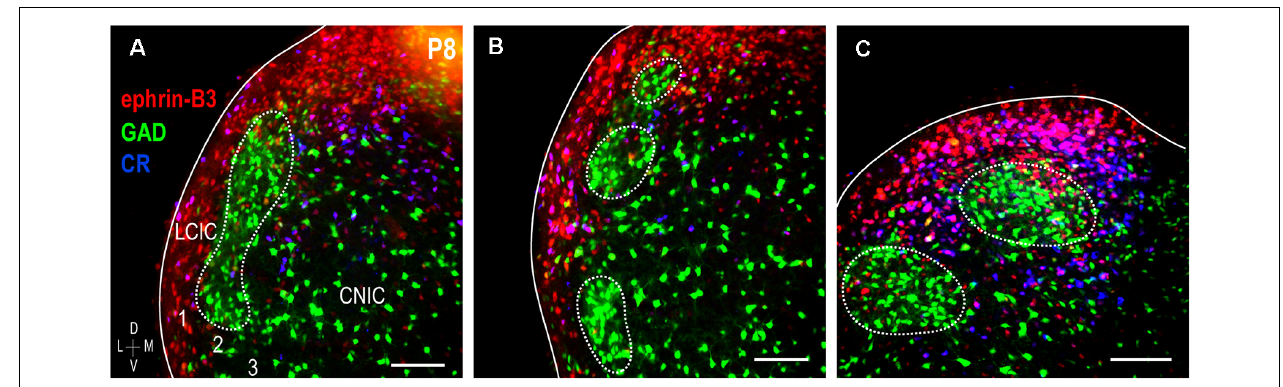
FIGURE 3 | Ephrin-B3 LCIC expression with respect to GAD (modular) and calretinin (CR; matrix) labeling at P8. Digital merges from a coronal series (A–C) through the modular extent of the LCIC at P8 [ephrin-B3 = red, GAD = green, calretinin (CR) = blue]. Dashed contours indicate the change in the appearance of GAD modules along the caudal-to-rostral dimension of the LCIC (in keeping with that previously described, see Dillingham et al., 2017; Gay et al., 2018). The ephrin-B3 expression is strong throughout the coronal series, exhibiting patterns complementary to GAD-positive modules that overlap the calretinin-defined matrix. Within layers 1 and 3 and intermodular bridges that together comprise extramodular regions, many calretinin-positive cells are also positive for ephrin-B3 (purple). Scale bars = 100 µ m.